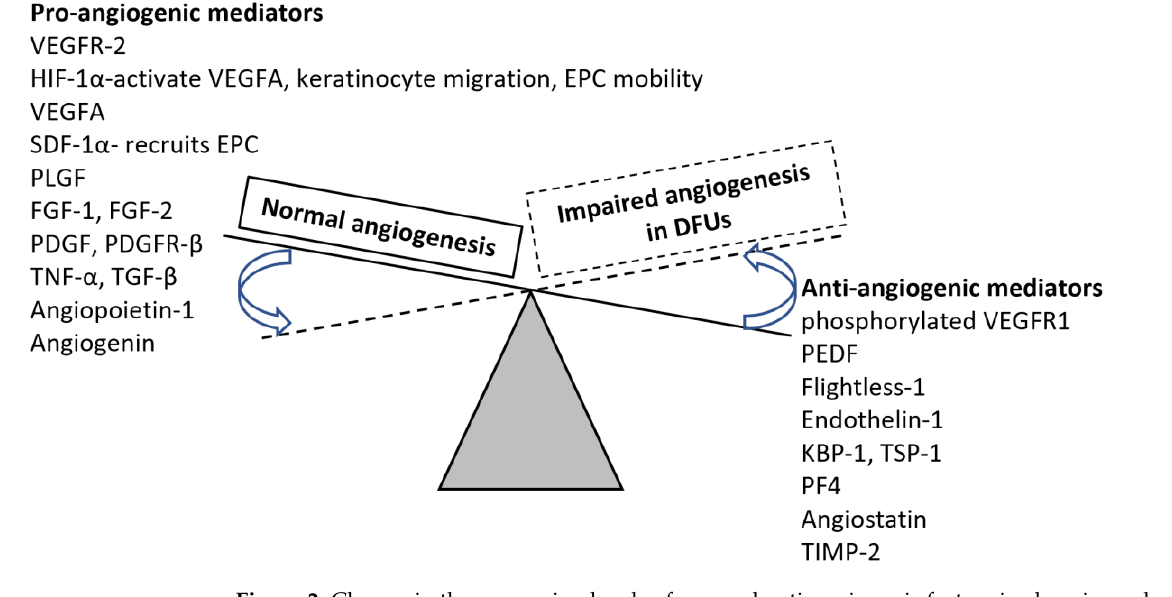
Table 1. Advantages and limitations of the stem cells enhancing healing in DFUs . Stem cells showed improved clinical efficacy in enhancing wound healing in DFUs by increased angiogenesis and re-epithelialization [17]. The common side effects associated with stem cell therapy are whole body urticaria, diarrhea, oral ulceration, the elevation of serum creatinine level, number, and differenti- ated potential decline with aging, nausea, and vomiting. Bone marrow-mesenchymal stem cells (BM-MSCs), umbilical cord blood-